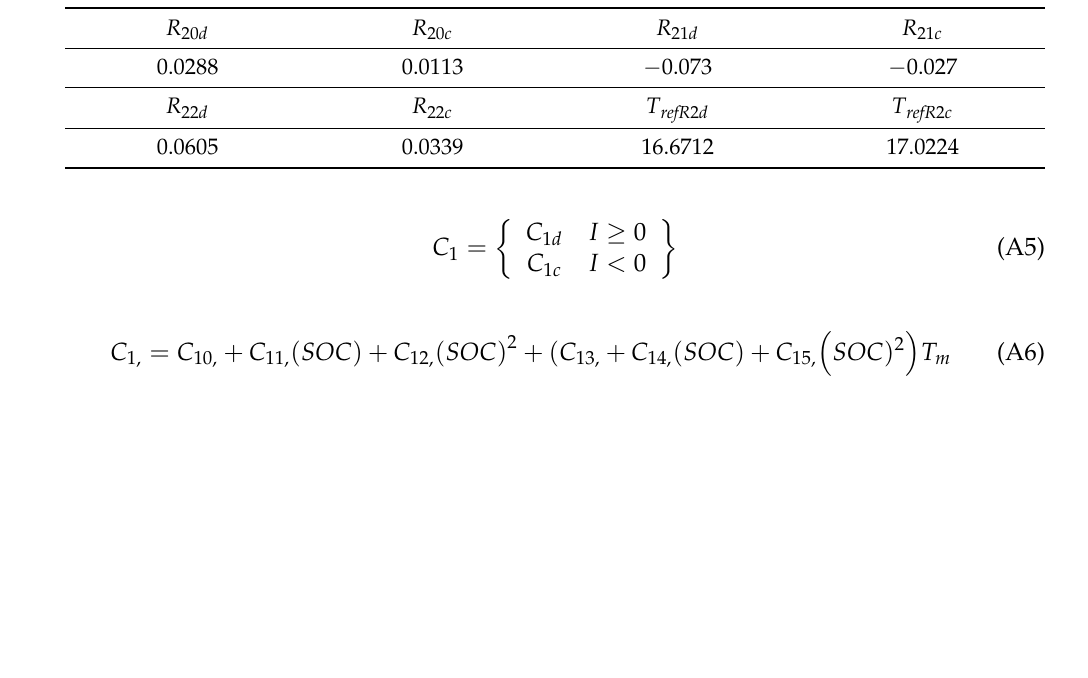
Table A2. Parametric R 2 Function